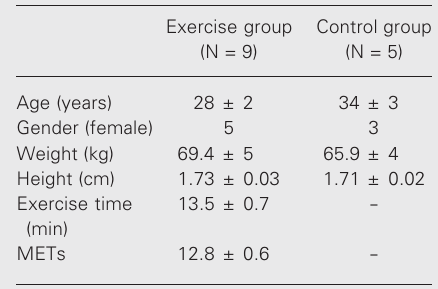
Figure 1. Forearm blood flow during baseline and reactive hyperemia calculated as the area under the curve (AUC). AUC for flow vs time was measured before and after the exercise test. Flow was higher for the baseline meas- urement only at 10 min after physical effort (upper panel). Values for reactive hyperemia were higher at 10 and 60 min after exercise (lower panel). *P < 0.05 vs before exercise; + P < 0.05 vs 10 min after ex- ercise (ANOVA for repeated test).+ measures with the post hoc Bonferroni